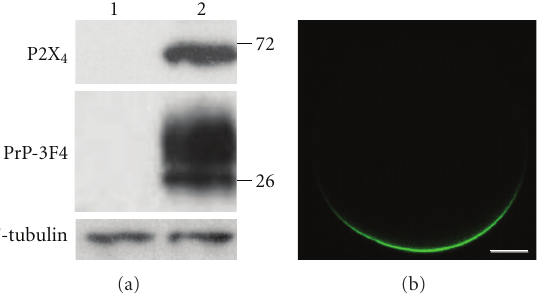
Figure 1: Coexpression of P2X 4 and PrP C in X. laevis oocytes. (a) Western blot of total lysate fractions from a non-injected oocyte ( left lane , 1) and from an oocyte co-expressing P2X 4 receptor and PrP- 3F4 ( right lane , 2). Numbers on the right are molecular weights in kDa. (b) Fluorescence microscopy of an oocyte co-expressing P2X 4 receptor and PrP-GFP (green), bar = 10 μ M.